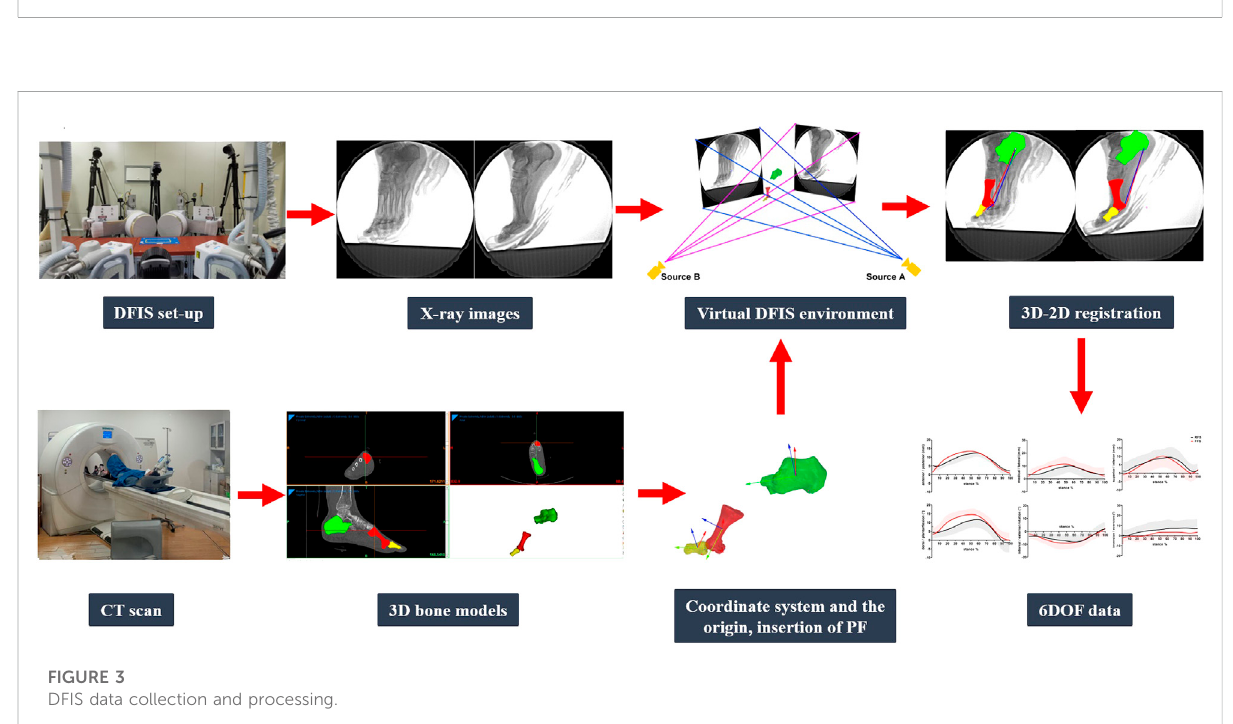
FIGURE 3 DFIS data collection and